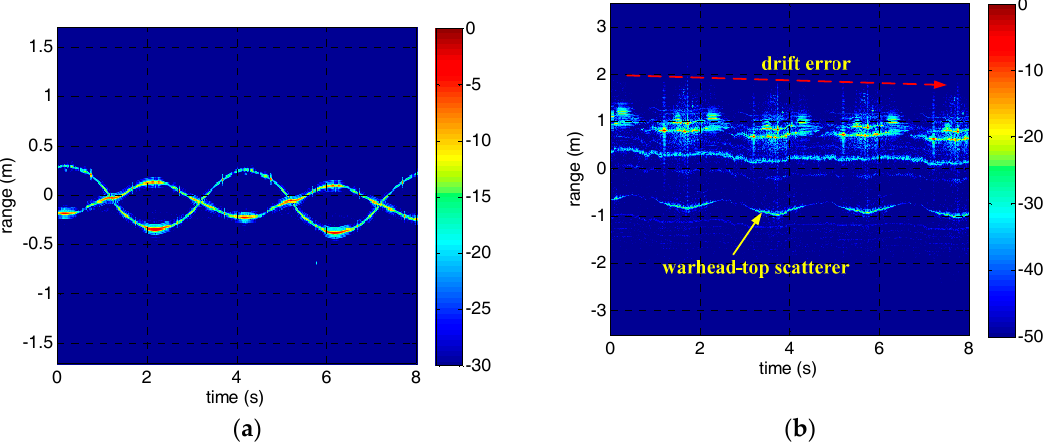
Figure 8. The HRRPs of the micro-motion targets after jump error correction. ( a ) The HRRP of the corner reflectors. ( b ) The HRRP of the warhead model.